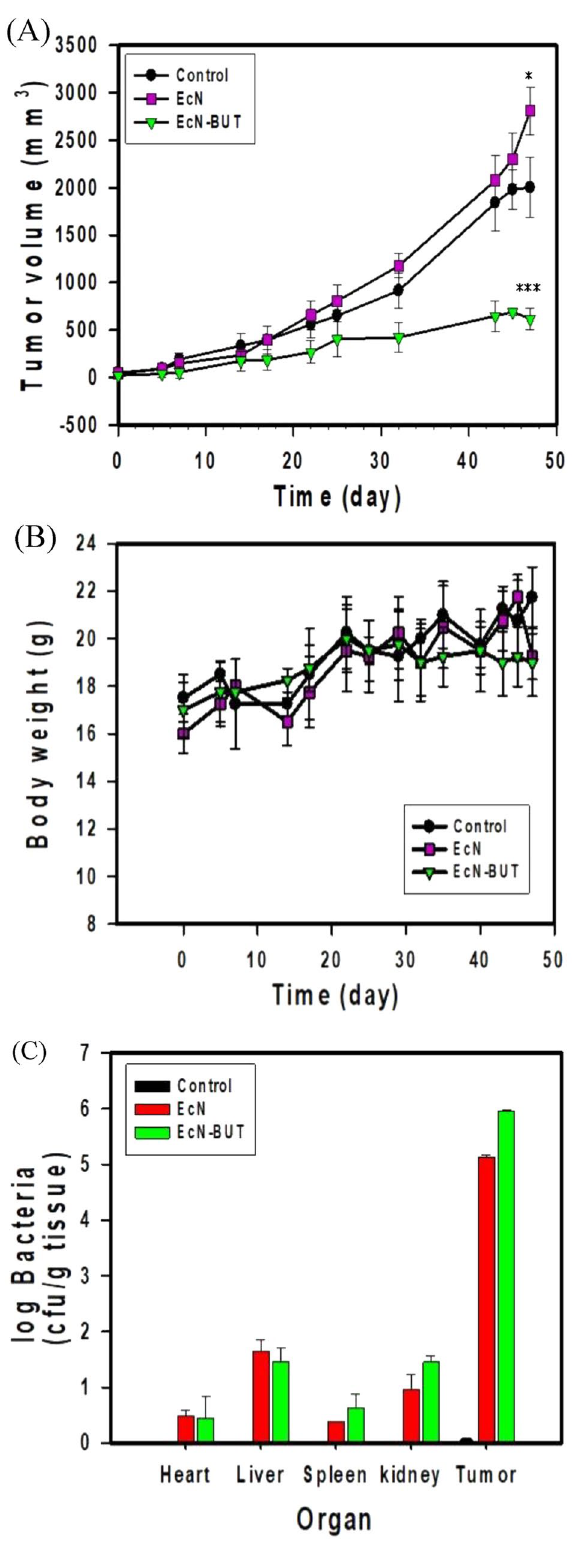
Figure 6. Tumor regression by EcN-BUT. ( A ) Therapeutic effect of EcN-BUT on mice (n = 5) bearing HT29 tumor cells. The tumor-bearing mice were administrated with EcN-BUT, EcN, or PBS (control). Tumor volumes (mm 3 ) were estimated using external calipers, and values were expressed as means ± standard deviations. The statistical analysis was performed with Tukey’s test (* p < 0.05, **p < 0.01 and *** p < 0.001) and graphs were prepared using SigmaPlot 10.0 (Systat Software, San Jose, CA). ( B ) Body weights of mice. The change in the body weight of mice was measured upon the treatment and graphs were prepared using SigmaPlot 10.0 (Systat Software, San Jose, CA). ( C ) Distribution of bacteria in vivo and graphs were prepared using SigmaPlot 10.0 (Systat Software, San Jose,